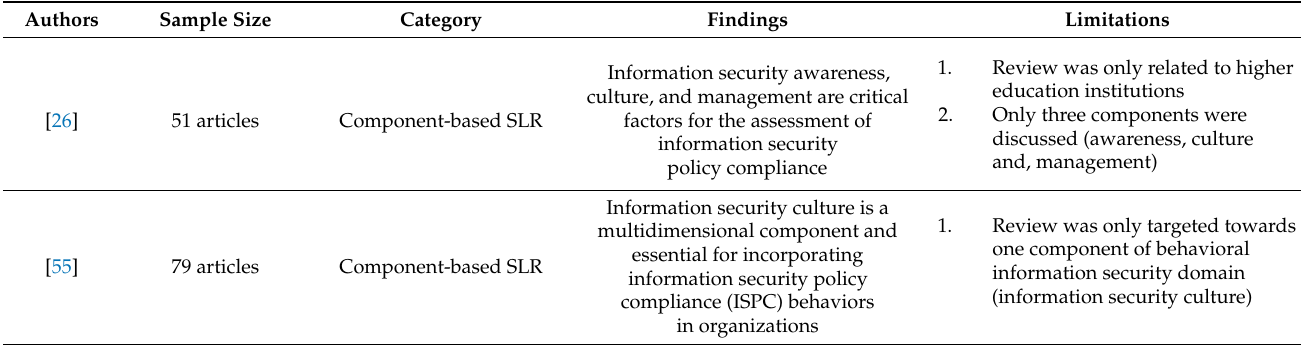
Table 1. Comparison with existing literature (limitations of existing